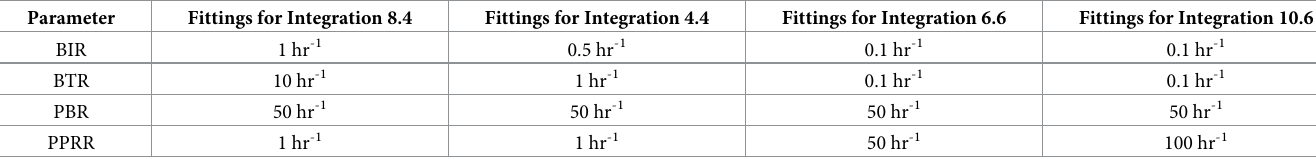
Table 2. Parameters selected for experimental fitting with PPRR activation. Parameter Fittings for Integration 8.4 Fittings for Integration 4.4 Fittings for Integration 6.6 Fittings for Integration